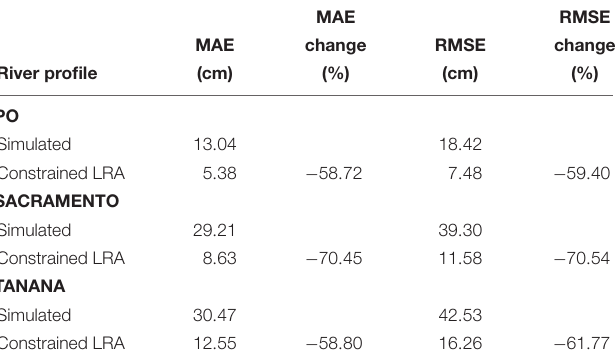
TABLE 2 | Error statistics before and after the CLRA